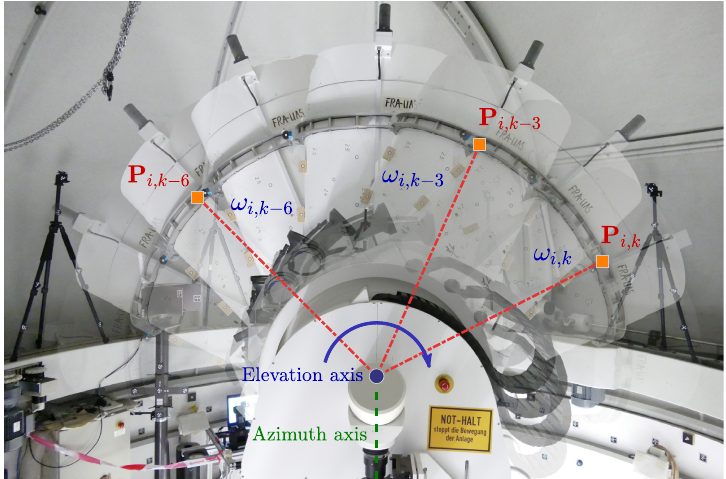
Figure 5. Symbolic illustration of the swivel-mounted laser telescope SOS-W. The azimuth axis is represented by a green dotted line. The elevation axis is depicted by a blue dot. A mounted marker p i , symbolized by an orange square, is shown in several telescope orientations denoted by the elevation angle ω